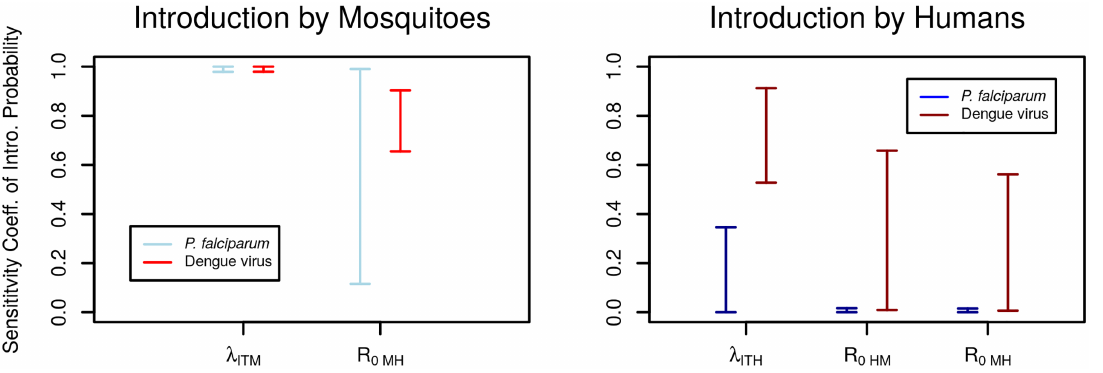
Fig 5. Sensitivity of introduction pathways to each individual step. Sensitivitycoefficients indicatethe percent changein the probabilityof introduction given a 1% changein each individual parameter (S1 Text). The probabilityof travel and the prevalenceof infectionare combinedin the parameters λ ITM and λ ITH